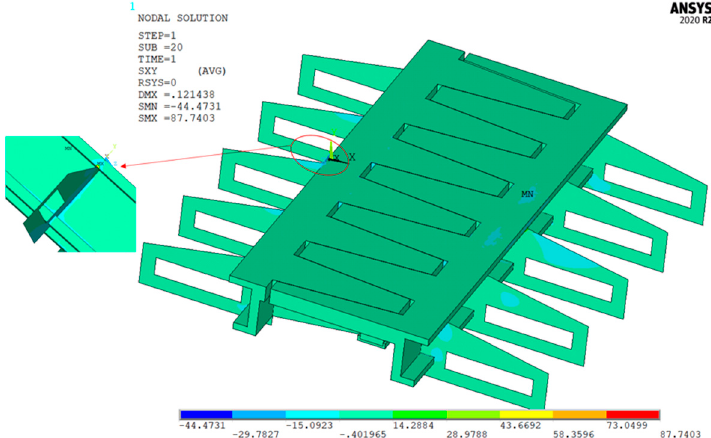
Figure 12. Shear stress diagram of the structure under working condition I.